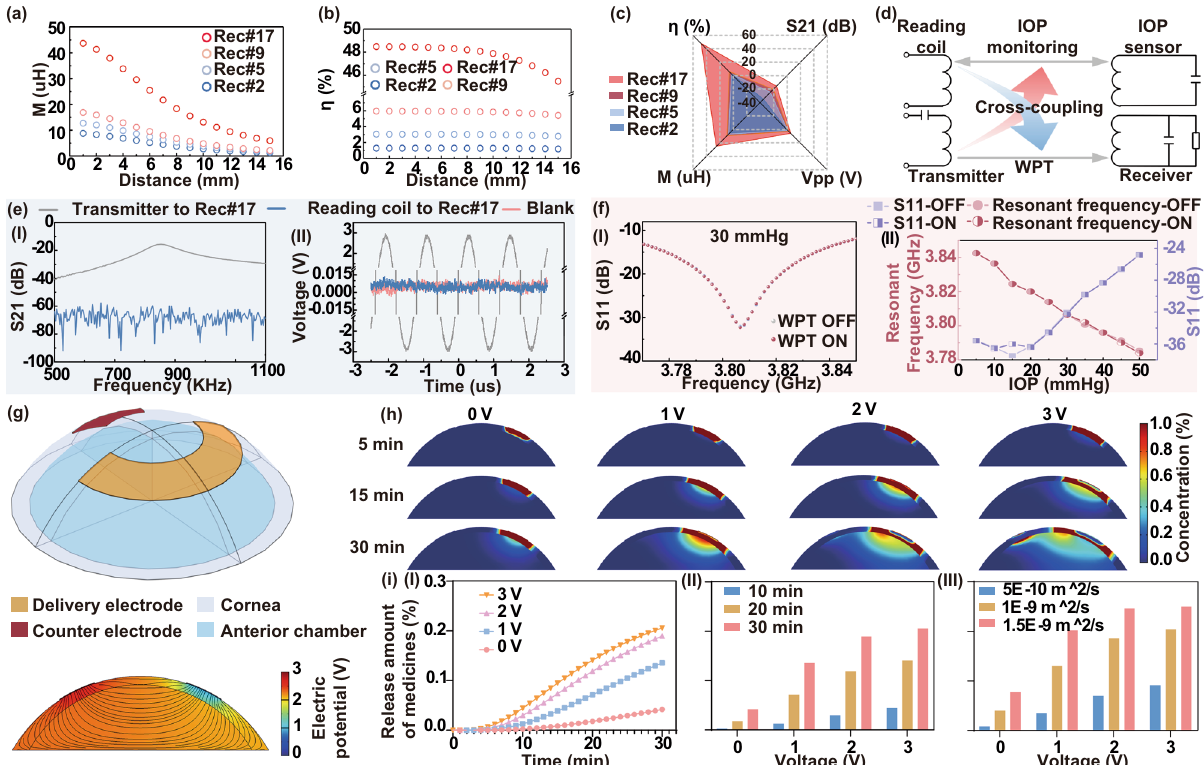
Fig. 5 Avoidance of cross-coupling and drug delivery simulation. a The mutual inductance and b Power transfer ef fi ciencies were theoretically calculated according to the circuit design of four receivers and the radiation distance. c Rader chart summarized performance (S21, Vpp, M, and η ) of etch WPT group (Rec#2, Rec#5, Rec#9, or Rec#17 linked to transmitter with 6 mm radiation distance and 850 kHz). d Schematic showing the experiments studying the cross-coupling between IOP monitoring and WPT module. The red arrow denoted the interference generated by the radiation of the WPT transmitter to the sensing module. The Blue arrow denotes the cross-coupling between the IOP reading coil and the WPT receiver. All examinations were performed with the radiation distance of 6 mm. e The IOP reading coil and WPT transmitter were coupled with the WPT receiver (using Rec#17), respectively, and the S21 indicated the coupling ef fi ciency and the generated voltages on the receiver radiated at 850 kHz were separately measured. f The WTCL was placed on the porcine eye at different IOP, and the reading signals (the resonance frequency and the S11) were recorded with or without the presence of radiation from the WPT transmitter. g The (top) 3D COMSOL model and (bottom) the simulated distribution pro fi le of electric potential and electric fi eld through the anterior region under the condition of iontophoresis at 3 V for t = 30 min. h The time slots of drug concentration pro fi le delivered by WTCL at various applied voltages (0, 1, 2, and 3 V). i The delivered amounts of drugs under different conditions, including the (I) applied voltages, (II) iontophoretic duration, and (III) assumed diffusivities, were systematically